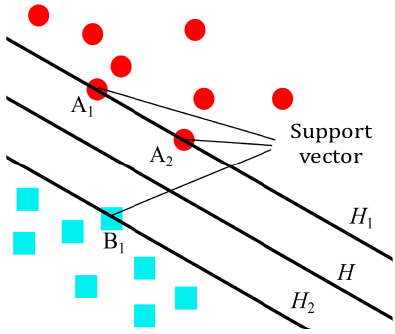
Figure 8. The optimal hyperplane.